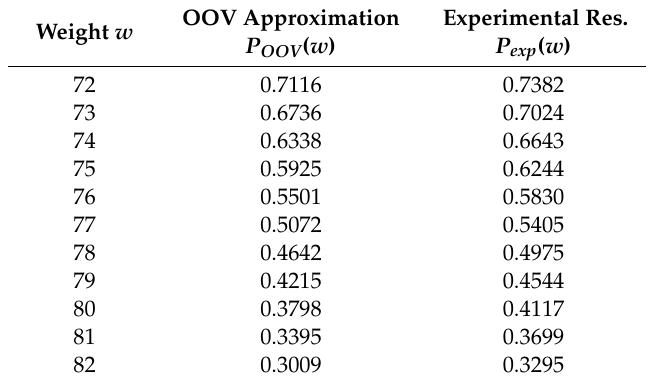
Table 2. Di ff erence between the OOV approximation and the experimental acceptance rates for the noise vectors with the Hamming weight close to w opt .